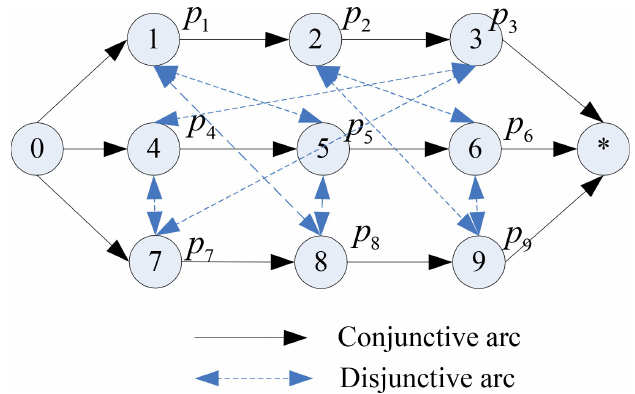
Figure 1. An illustration of a disjunctive graph for a job shop scheduling problem with 3 jobs and 3